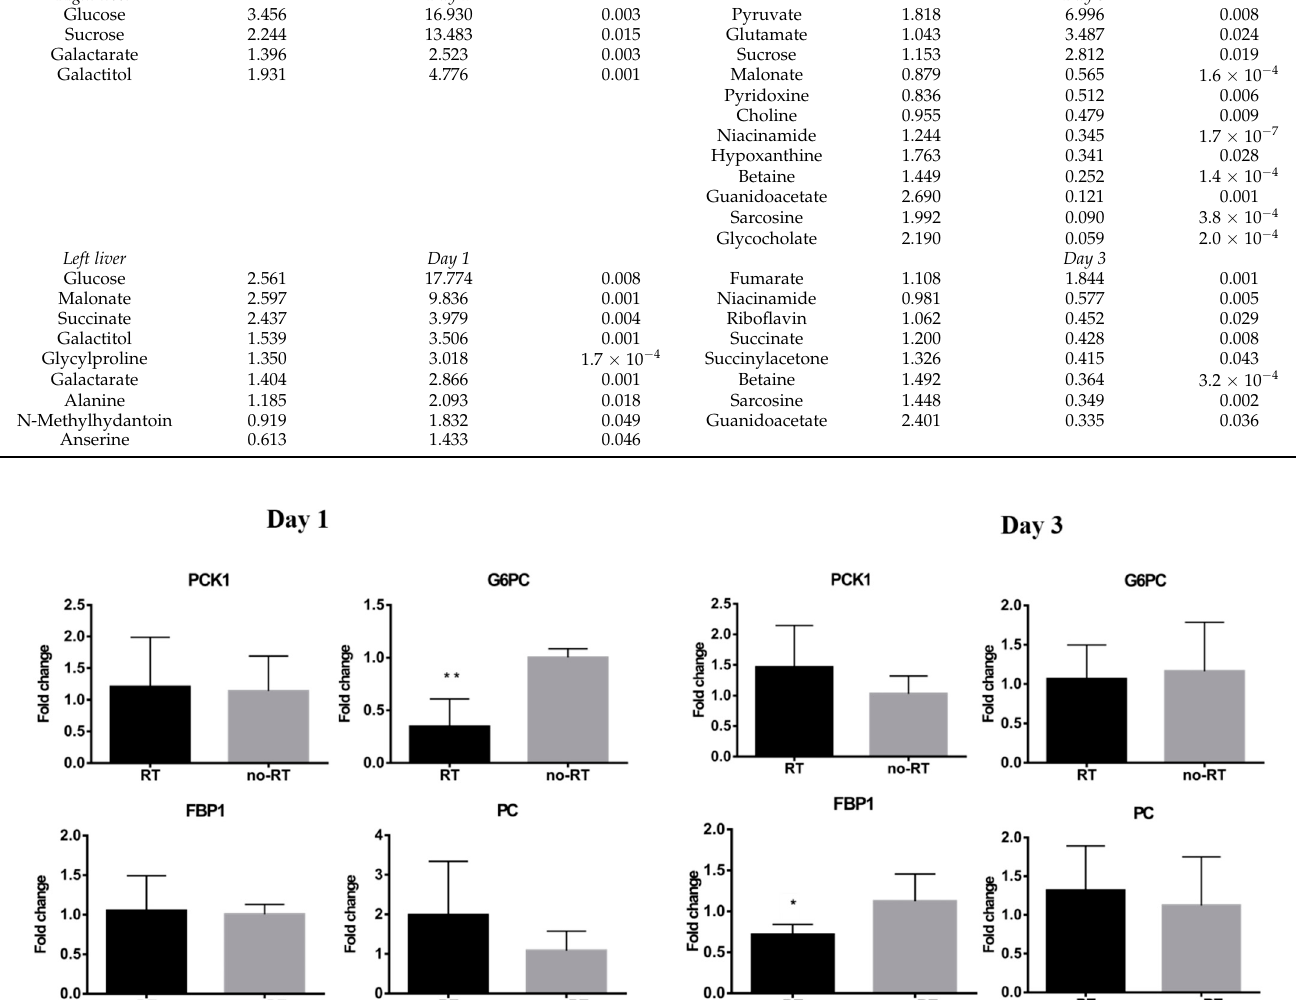
Figure 4. Expression levels of genes encoding for gluconeogenesis-associated enzymes in the RT ( n ≥ 3) and no-RT ( n ≥ 3) groups on the first and third post-irradiation days (right lobe of the liver). On the first post-irradiation day, the expression levels of the G6PC gene (expressed as fold-change) were significantly lower in the RT group. On the third post-irradiation day, the expression levels of the FBP1 gene (expressed as fold-change) were significantly lower in the RT group. These results indicate the temporal shift from gluconeogenesis to glycolysis in the irradiated liver parenchyma. * p < 0.05; ** p < 0.01